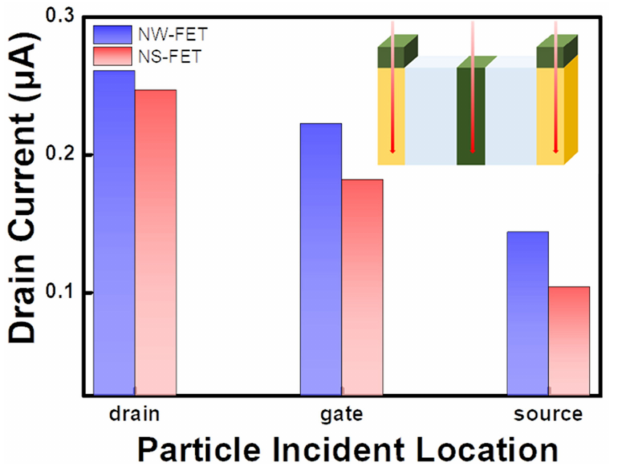
Figure 6. Comparison of drain currents with respect to particle incident location; the measurement time was set to 5